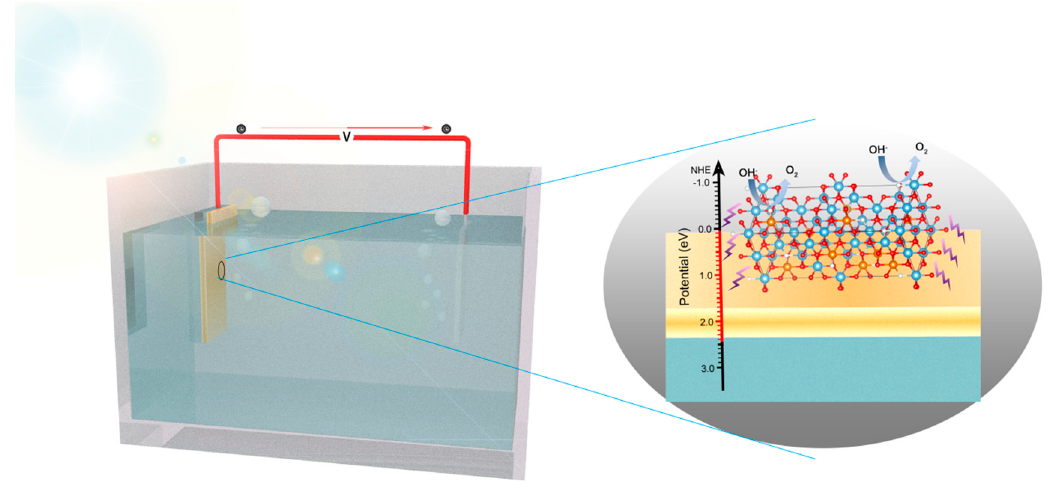
Figure 10. Proposed photocatalytic mechanism of TCT-2 sample under light irradiation.